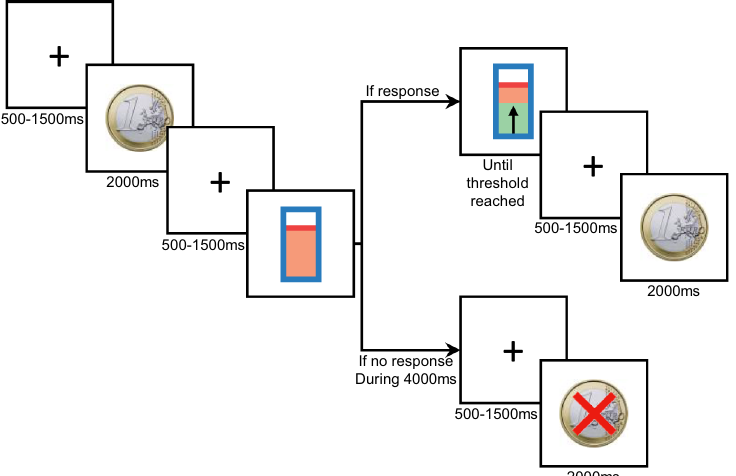
Figure 1. Experimental design of the